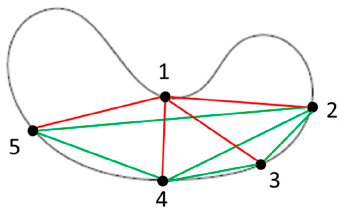
Figure 2. A closed curve possessing segments with differently signed curvatures is depicted. The curvature is positive at the black segment of the curvature and negative at the violet segment of the curve. Five points are placed on the curve. Green edges connect the points placed on the segments where the curvatures are of the same sign; red edges connect the points placed on segments where curvatures are differently signed.